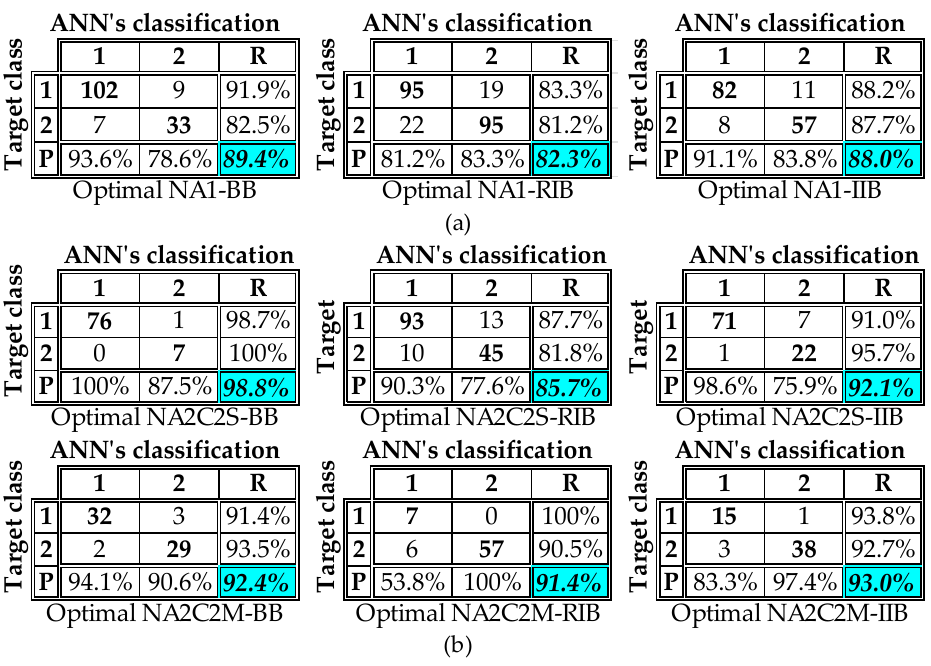
Figure 14. CMs extracted by the optimally configured networks of ( a ) A1 and ( b ) A2.